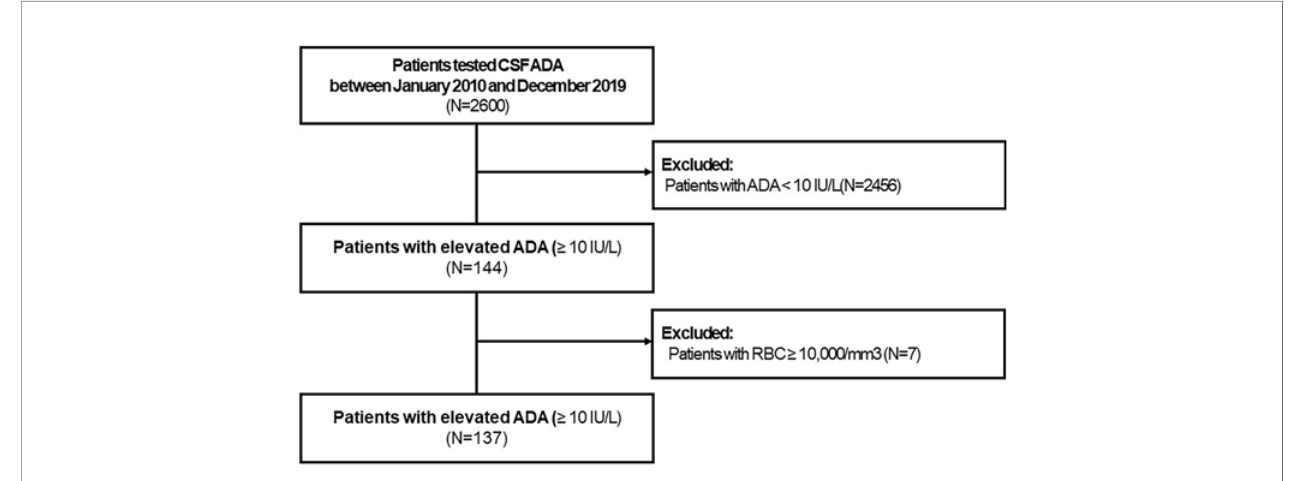
FIGURE 1 | Flowchart to describe the enrolled study population. CSF, cerebrospinal fl uid; ADA, adenosine deaminase; RBC, red blood cell.